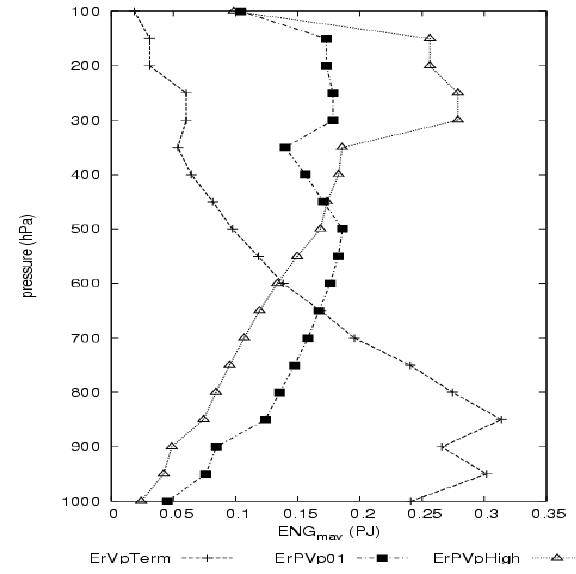
Fig. 7. Vertical profile of the mean absolute energy variation ( MAV ) of the initial conditions according to the positive percent- age found for each anomaly. ErPVpTerm (cross), ErPVp01 (filled square), ErPVpHigh (triangles). Note that the same area is enclosed by each curve (same total